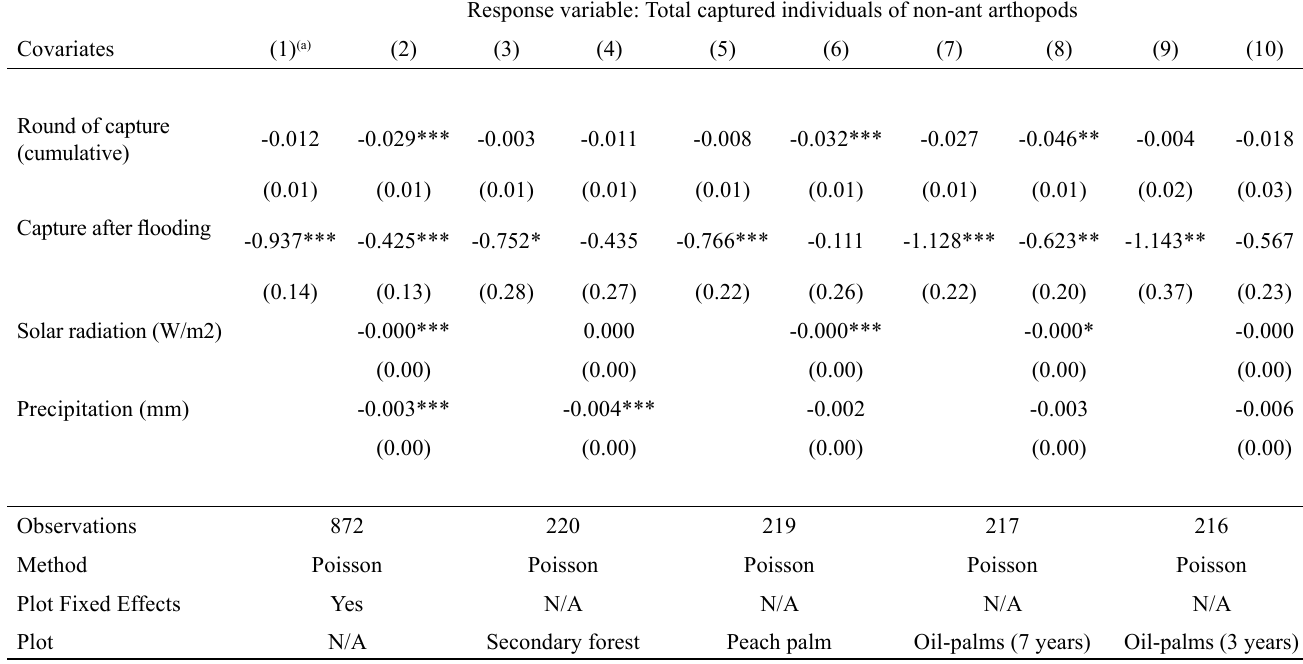
Table 2 . Estimated effect of pitfall trapping over non-ant arthropods by Poisson regression model.